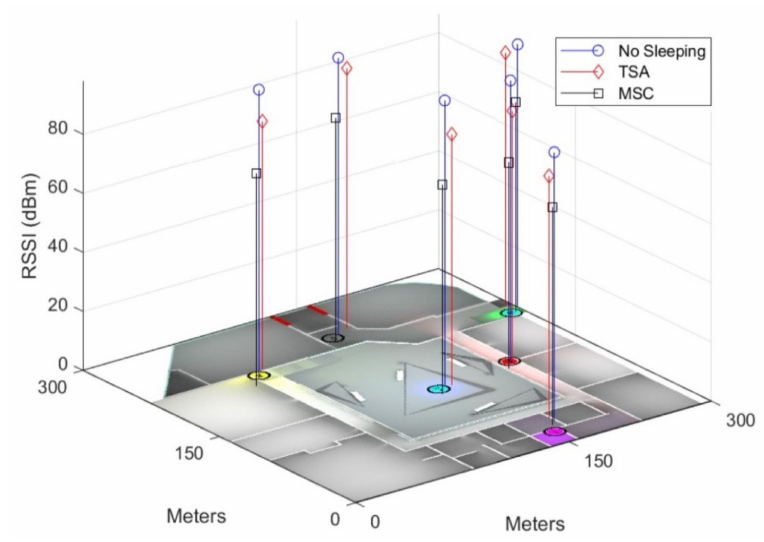
Figure 11. Analysis of the WiFi sensors under no sleeping, TSA, and MSC for MPH (proactive protocol).